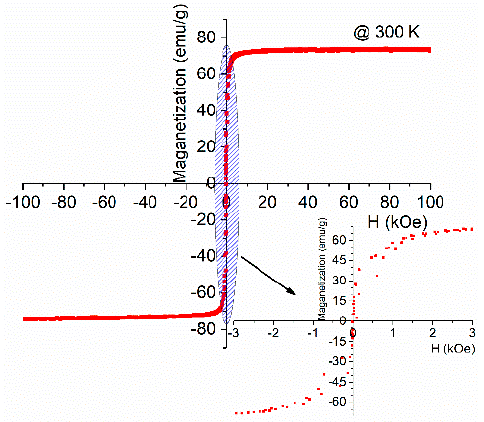
Figure 11. Hysteresis loop for sample PCW_1000 °C.